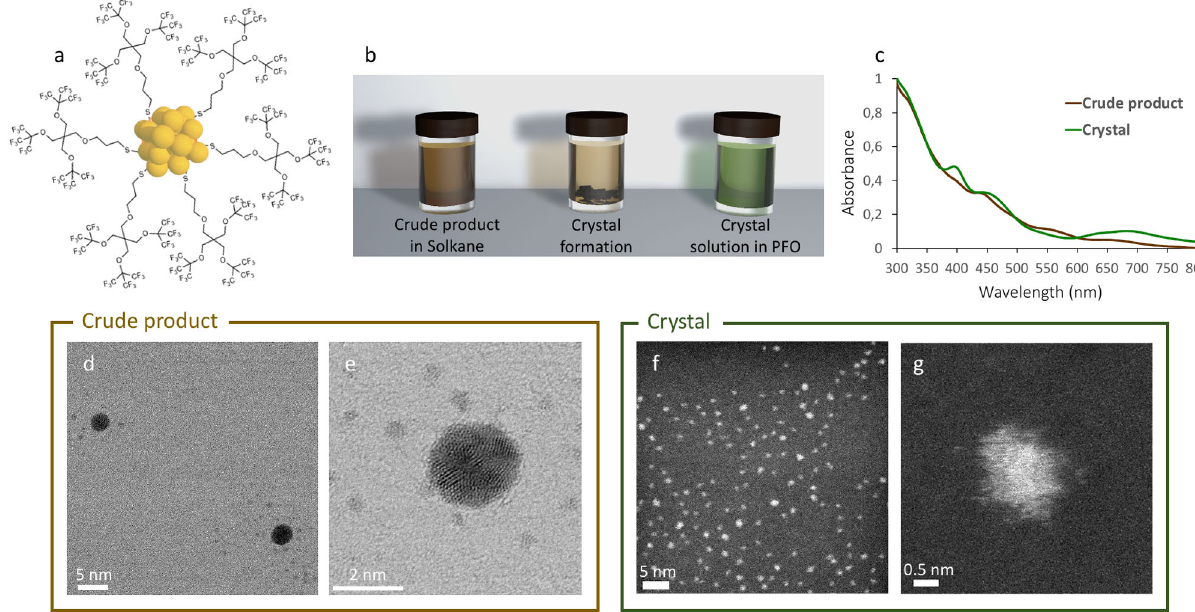
Fig. 2 Synthesis of AuNC stabilized by F 27 SH and crystallization of [Au 25 (SF 27 ) 18 ] 0 . a Cartoon representation of AuNC stabilized by F 27 SH thiol. For the sake of clarity, only 6 F 27 S-ligands have been reported; b schematic representation of crystal formation in solkane solution and colorimetric change upon their dissolution in PFO; c UV – Vis spectra of crude product in solkane and crystals redissolved in PFO; d , e STEM images of crude product showing the presence of small clusters and bigger AuNPs; f , g STEM images of redissolved crystals solution showing the homogeneous presence of small clusters. NATURE COMMUNICATIONS| (2022) 13:2607 |https://doi.org/10.1038/s41467-022-29966-2|www.nature.com/naturecommunications